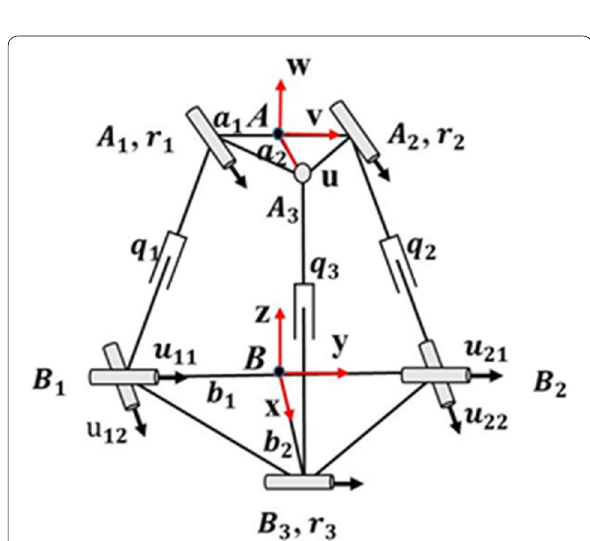
Figure 2 Parametric model of the parallel